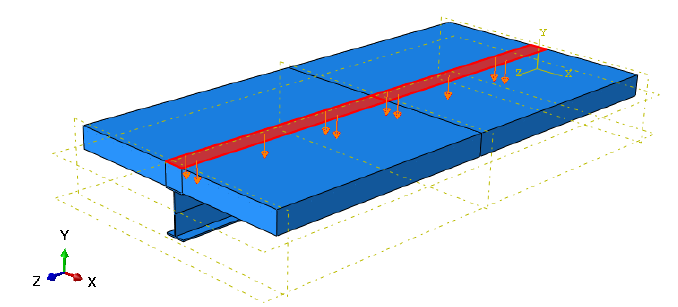
Figure 13. Distributed load application